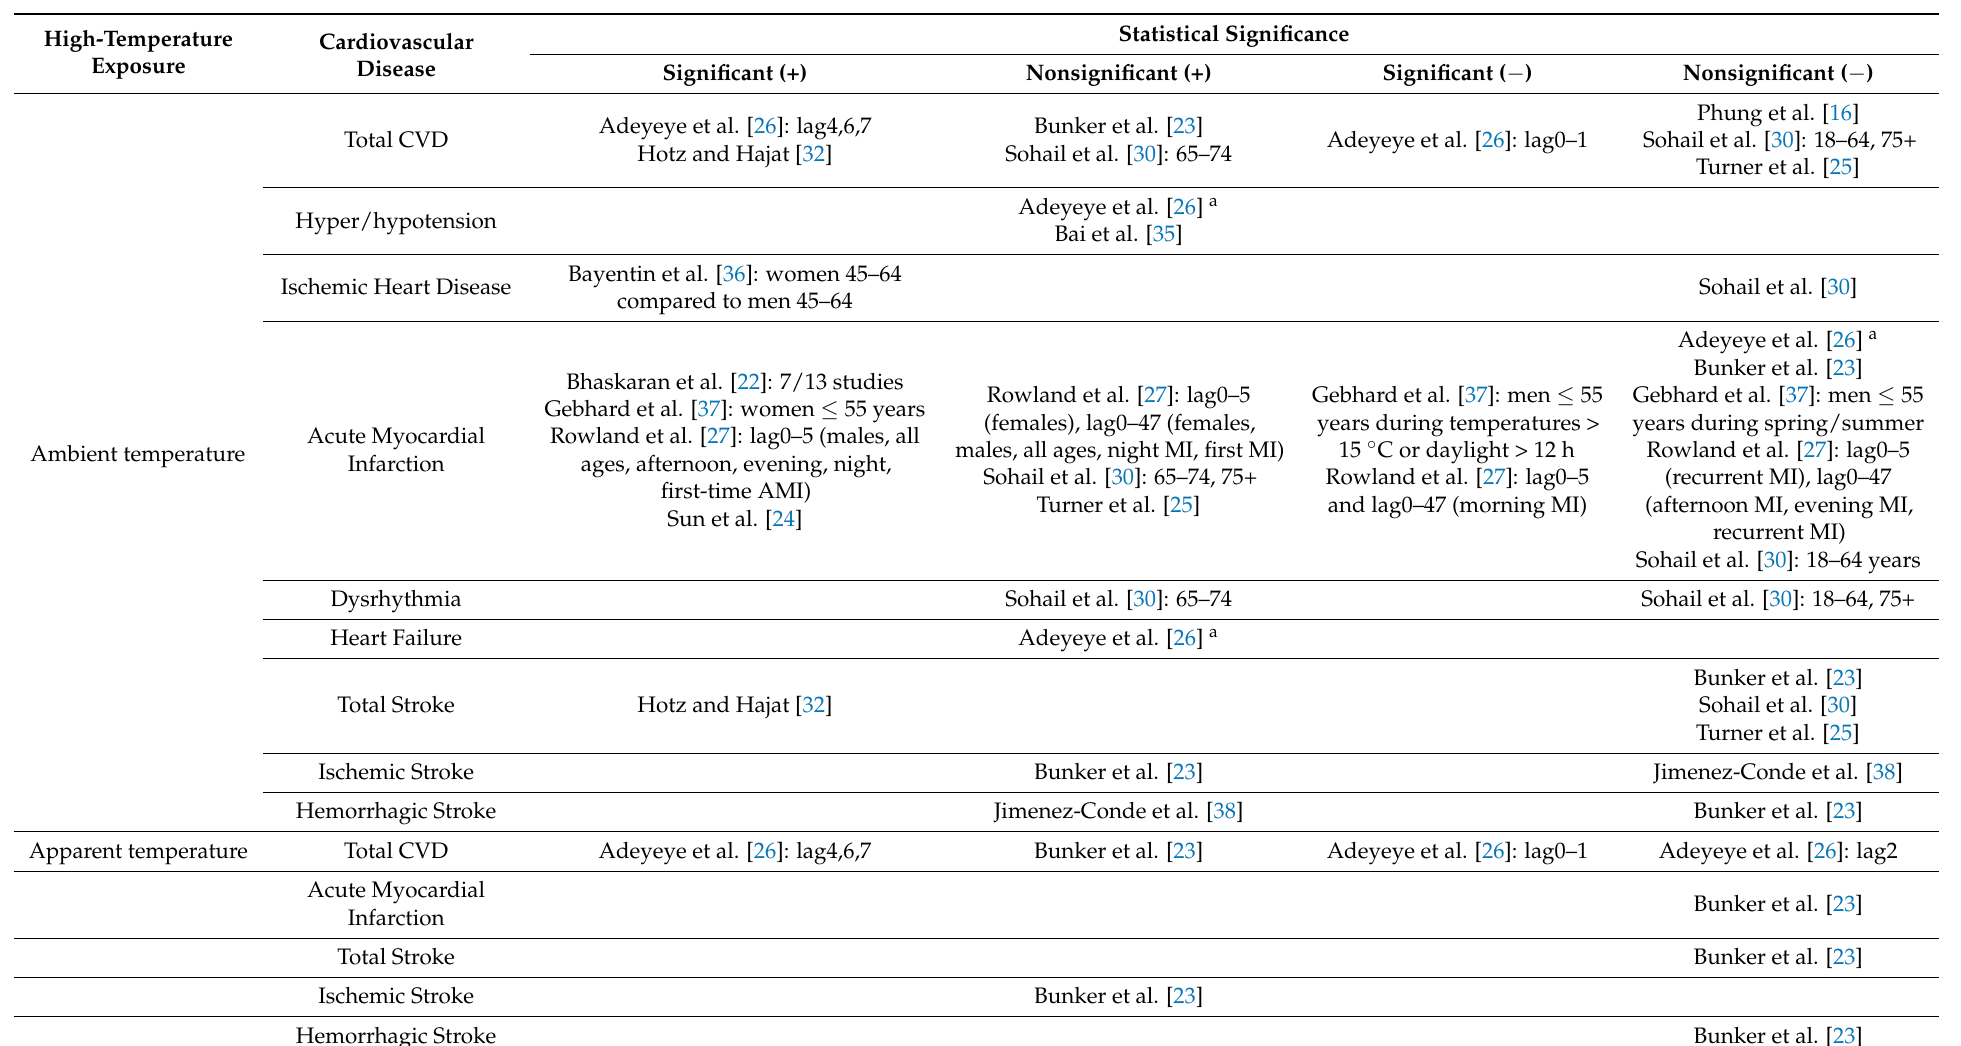
Table 3. Statistical significance and direction of effect between temperature exposures and